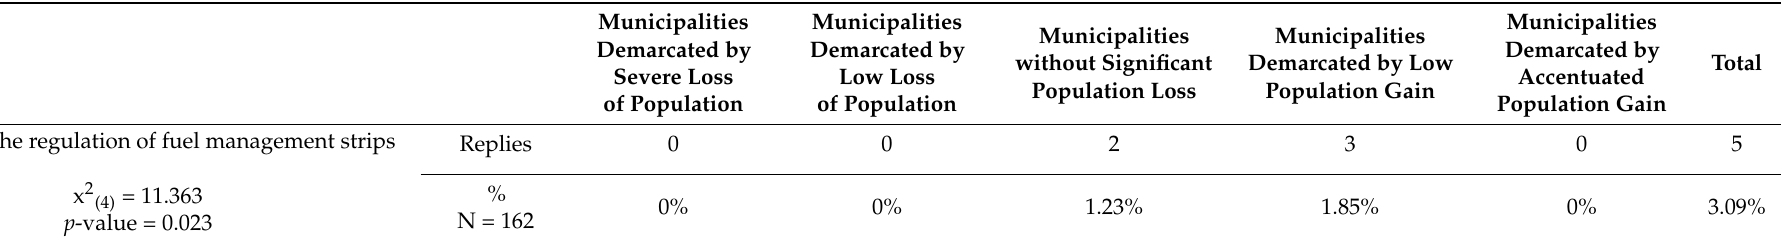
Table 2. Relationships with statistical significance established between the difficulty of rigidity in the regulation of fuel management strips and the degree of depopulation between 2011–2021.